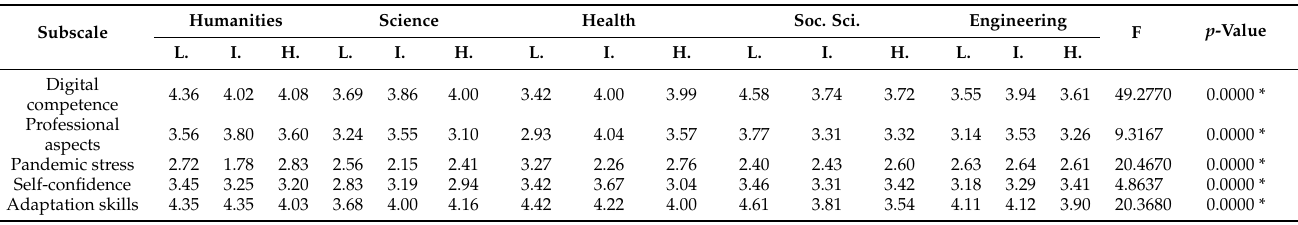
Table 8. Mean values differentiated by area of knowledge and MANOVA test